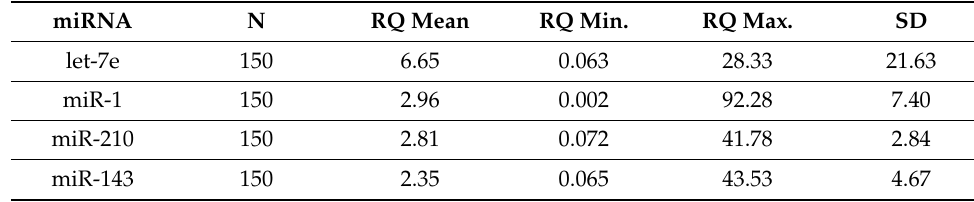
Table 3. Expression of miRNA in patients.